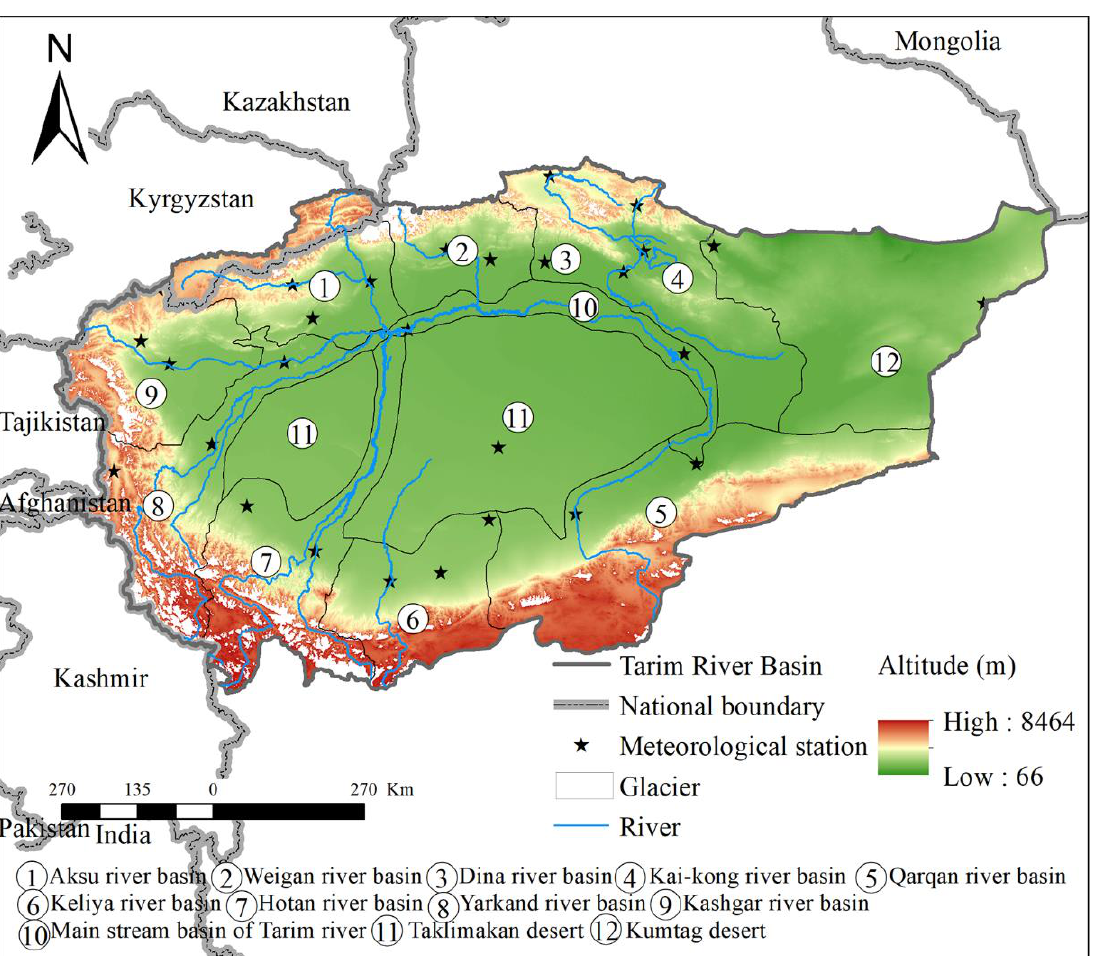
Figure 1. Location of the Tarim River Basin.